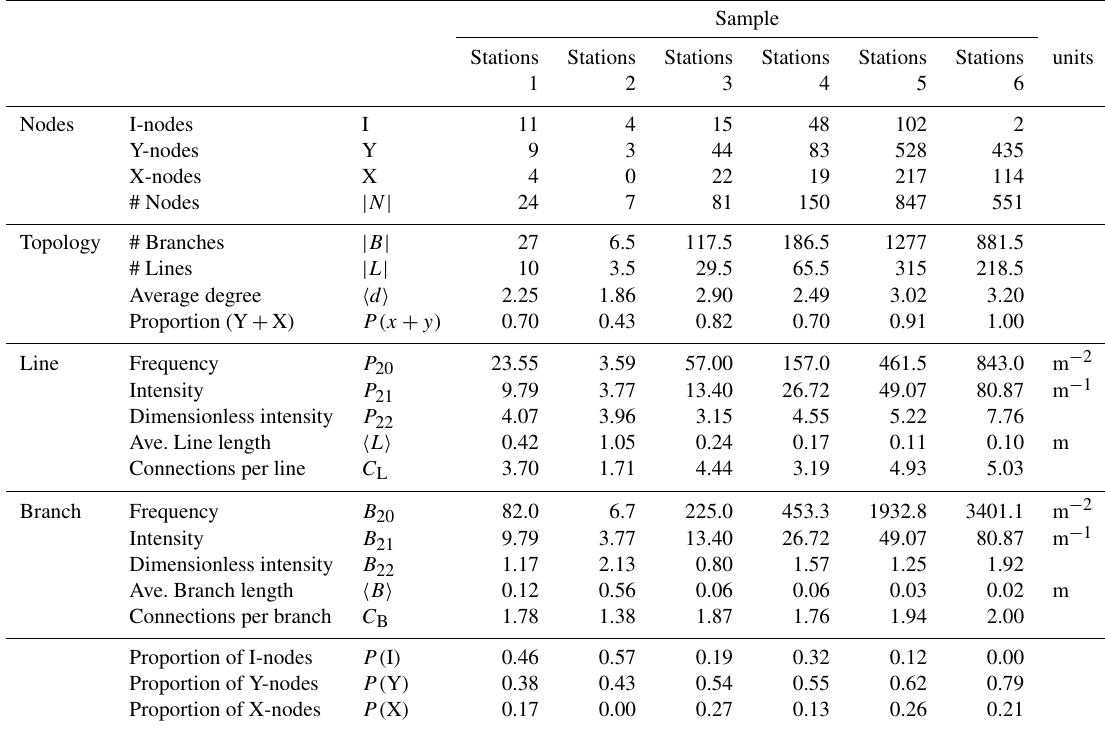
Table 1. Summary table showing total values for each structural station. Total values do not include hand specimens due to their small size making estimates of frequency and intensity unreliable, though trends for samples do match those for outcrops in this study. For details on individual scan circles see the